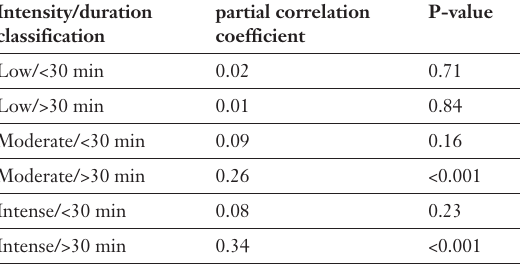
Independent asso- ciation of sweat fre- quency with physical activities of varying intensity and